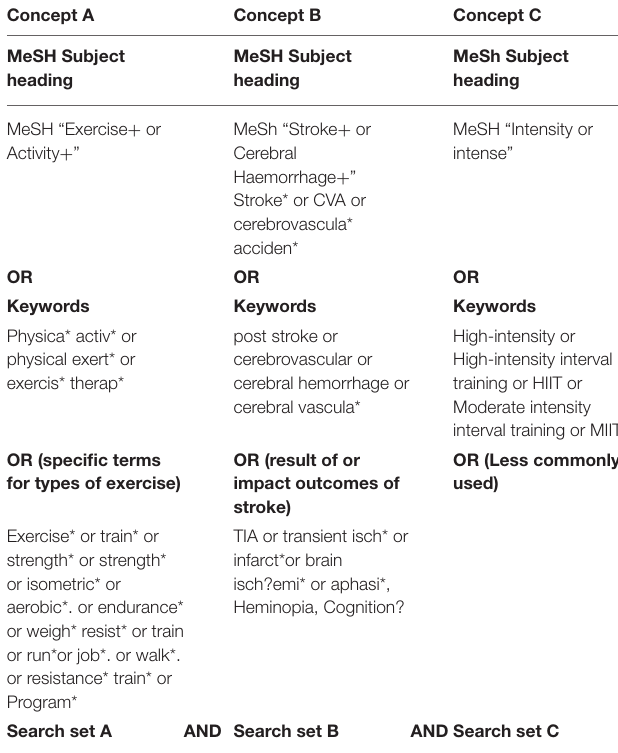
TABLE 2 | Example of search strategy including concepts, key words and MeSH